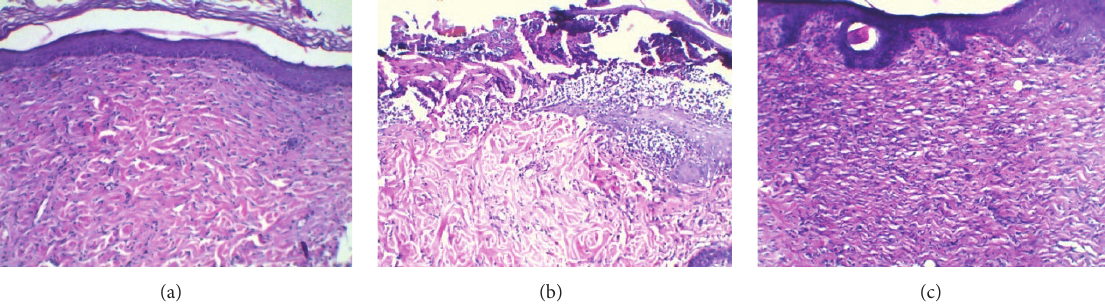
Figure 1: Photomicrographs of H-E staining in the wound tissue of each group ( × 100). (a) Nondiabetic control rats showed reepithelialization around the wound. (b) Inflammatory cell infiltration was observed in the wound from diabetic rats treated with vehicle. (c) Reepithelialization was observed in the wound from diabetic rats treated with hemin.